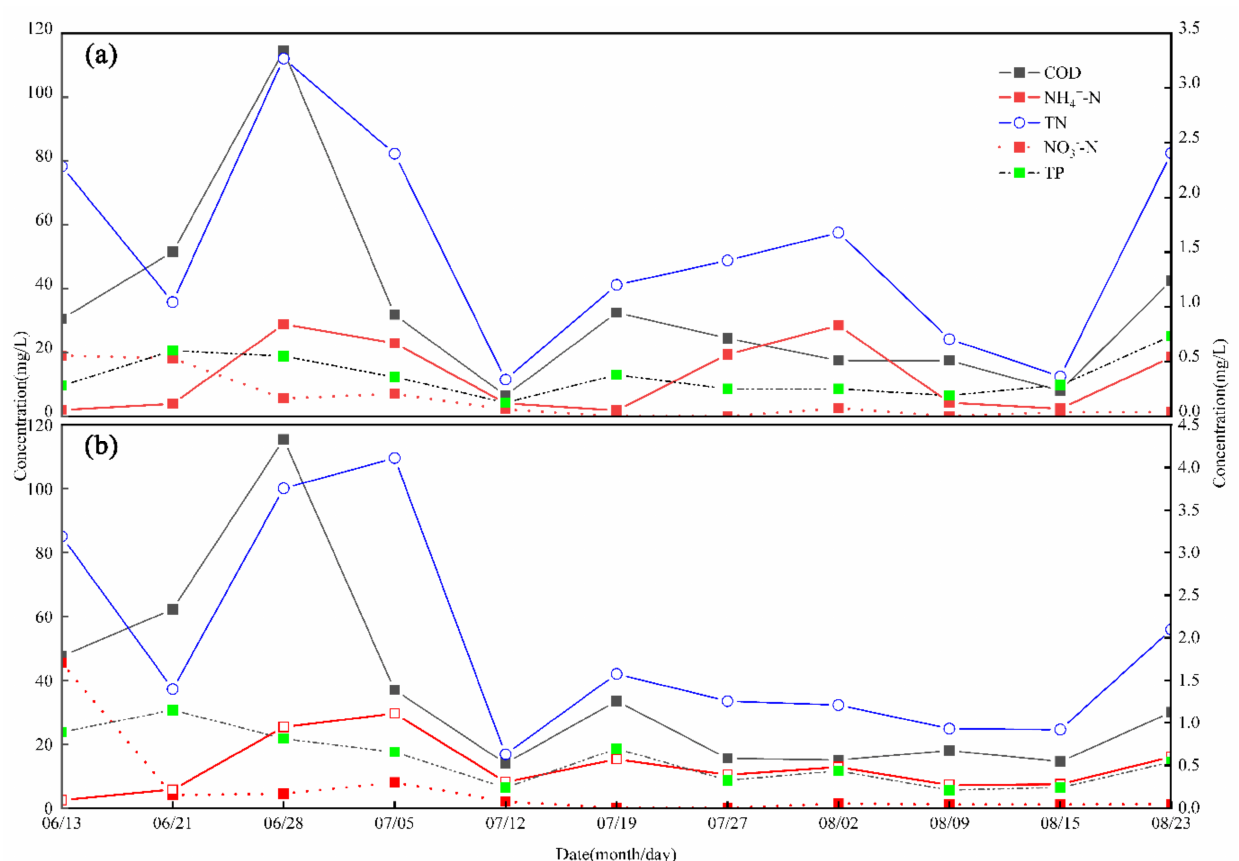
Figure 5. Changes in the basic water quality indicators in the surface runoff at points 1# and 2#; ( a ) describes the changes in COD, TN, TP, NH 4+ -N, and NO 3 − -N at 1# point, and ( b ) describes the changes in COD, TN, TP, NH 4+ -N,and NO 3 − -N at 2#